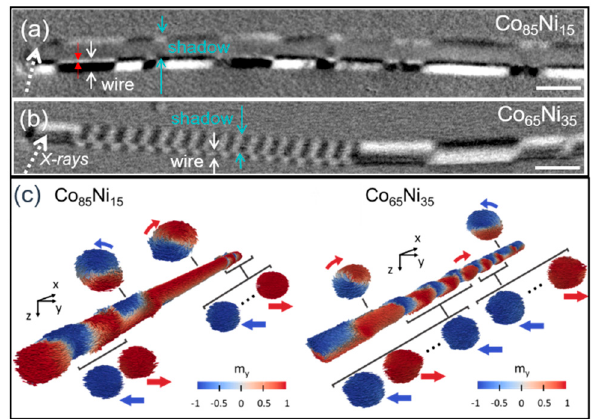
Figure 14. XMCD-PEEM images of ( a ) Co 85 Ni 15 and ( b ) Co 65 Ni 35 nanowires. The scale bar is 1 μ m, and the arrows (dash white) indicate the incident X-ray beam, ( c ) micromagnetic simulations of Co 85 Ni 15 (left) and Co 65 Ni 35 (right) nanowires. Adapted with permission from ref. [20]. Copyright 2017 American Physical Society.